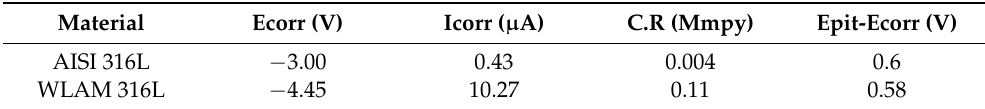
Table 2. Electrochemical parameters derived from potentiodynamic polarization analysis shown in Figure 9.